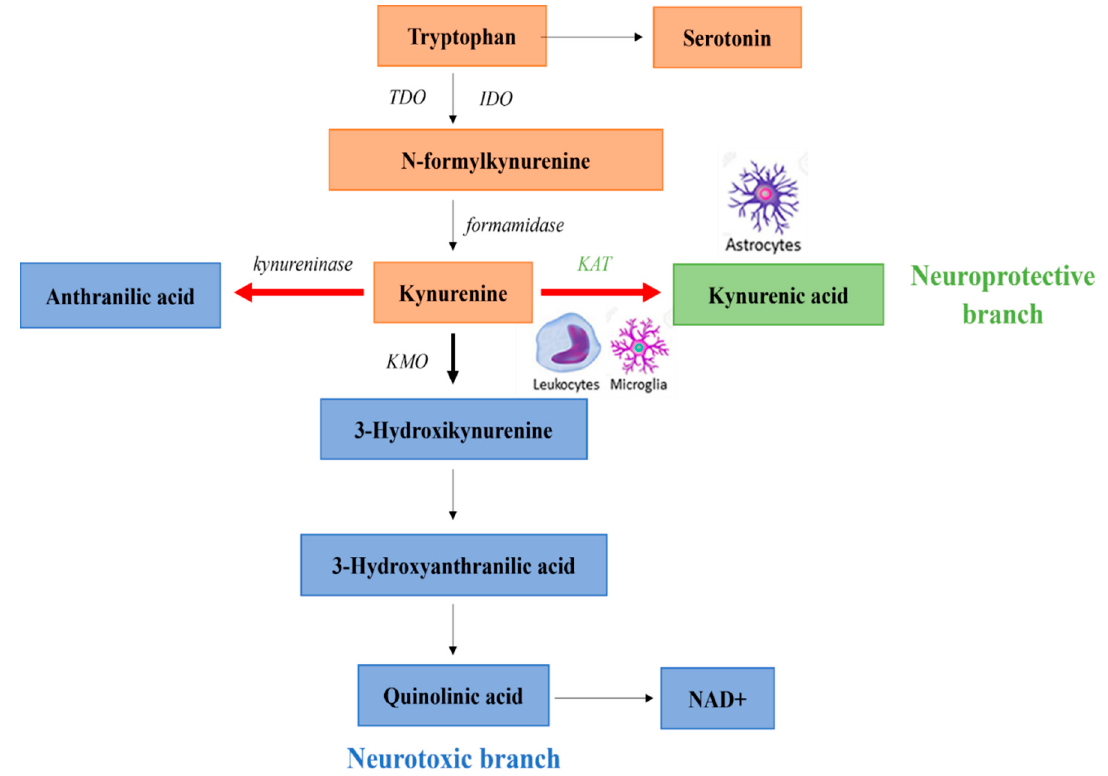
Figure 2. Kynurenine pathway (KP) in normal and schizophrenic subjects. The thick black arrow indicates the primary normal direction of KP. The thick red lines denote shifting in the direction of KP in schizophrenia. Abbreviations : IDO: indoleamine 2,3-dioxygenase, KAT: kynurenine aminotransferase, KMO: kynurenine 3-monooxygenase, NAD+: nicotinamide adenine dinucleotide, TDO: tryptophan 2,3-dioxygenase.